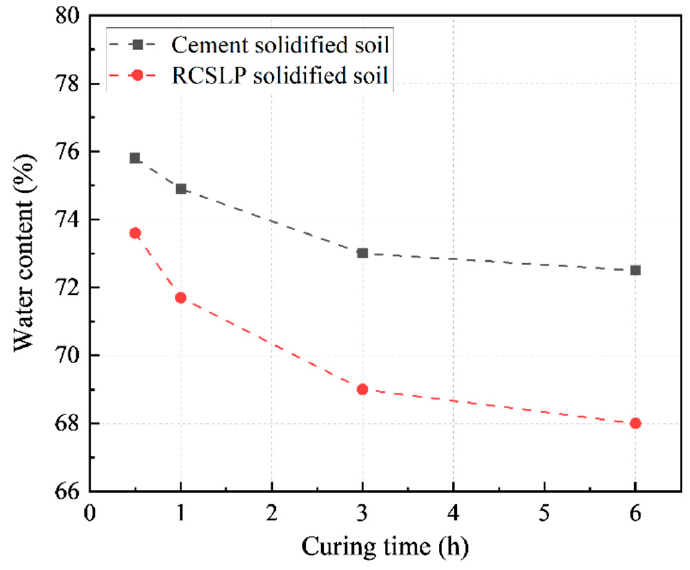
Figure 5. Moisture content variation of the solidified soil with curing time.